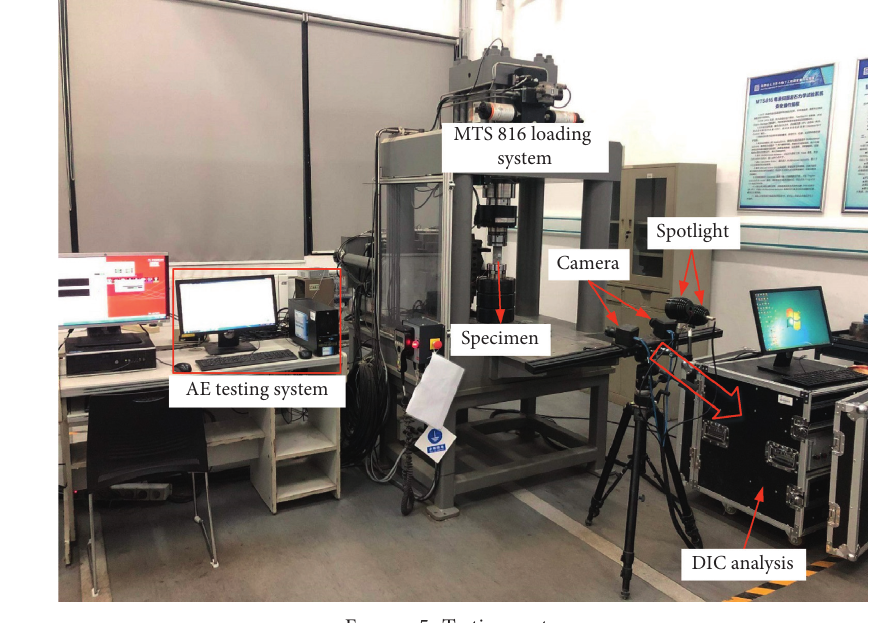
Figure 5: Testing system.